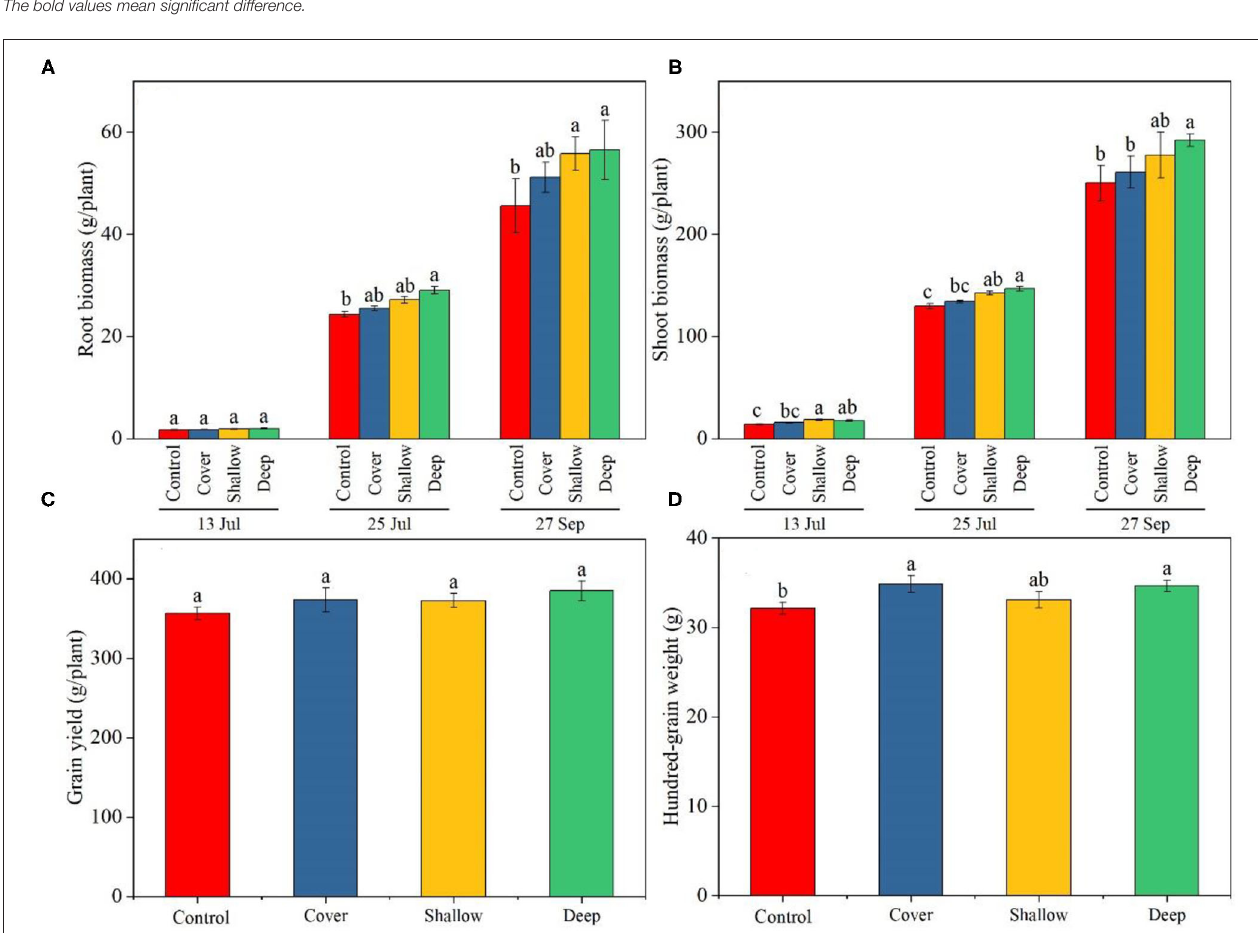
FIGURE 1 | Biomass of maize roots (A) and shoots (B) on the three sampling dates (13 Jul: early jointing, 62 days after sowing (DAS); 25 Jul: late jointing, 74 DAS; 27 Sep: grain maturity, 138 DAS) and grain yield (C) and 100-grain weight (D) at maturity. Means ± SE ( n = 3). Different letters denote significant differences among treatments on a specific sampling date (A,B) or among the treatments (C,D) ( P < 0.05). Control, no straw added; Cover, straw added to the soil surface; Shallow, straw incorporated at the 0–20cm soil depth; Deep, straw incorporated at the 20–40cm soil depth.